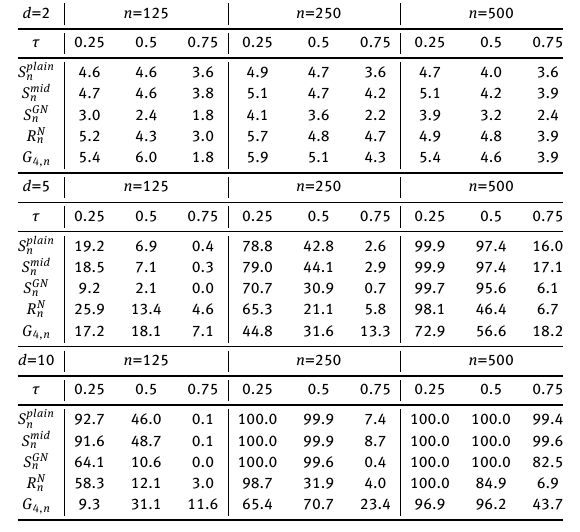
Table 11: Percentages of rejection at a 5% significance level, as estimated from 1000 replicates, for the tests based on S plain n , S mid n , S GN n , R N n and G 4, n under the Frank copula. d